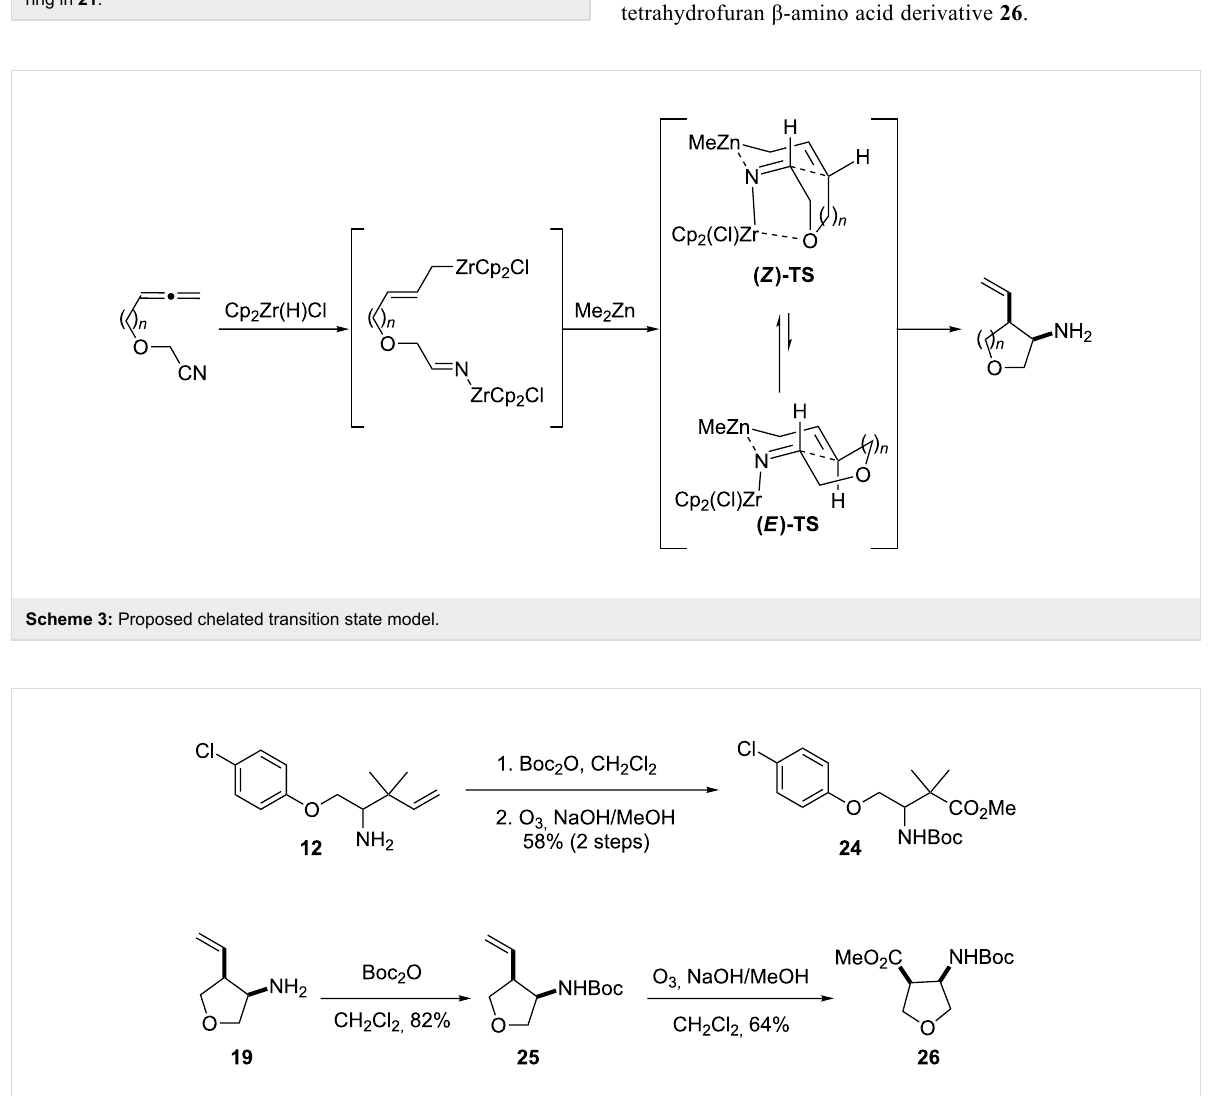
Figure 1: Coupling constant analysis of the Boc-protected aminopyran ring in 21